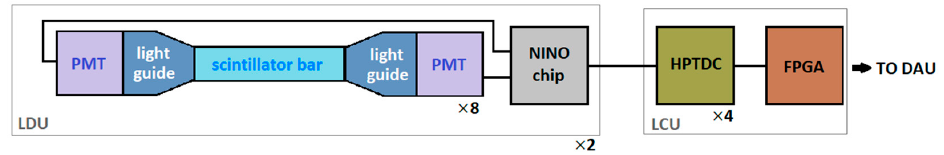
Figure 2. Sketch of the LIDAL components devoted to the processing of signals coming from the scintillator bars. Each LDU is composed of eight plastic scintillators, optically coupled with photomultipliers. Signals from 16 PMTs (one LDU) are processed by 2 NINO chips. The LCU manages data coming from both LDUs and interfaces with the DAU. 4 HPTDCs convert signals from NINO chips into time signals, which are then sent to an FPGA, then processed and sent out to the DAU.